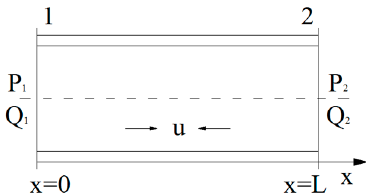
Figure 5. Fluid element of one dimension.